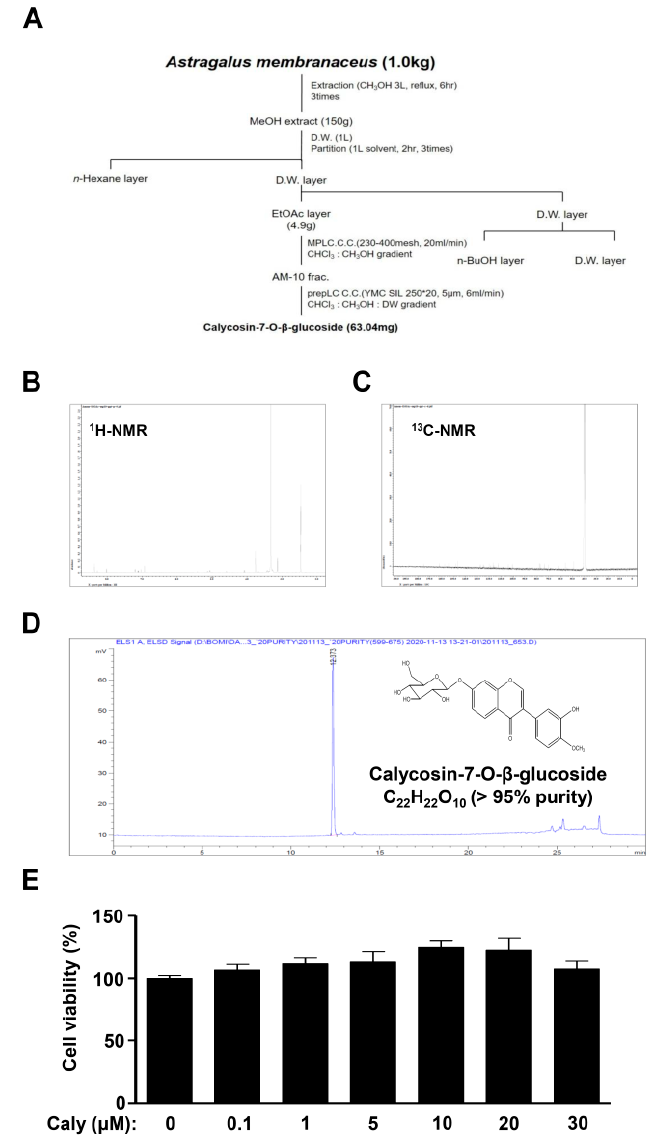
Figure 1. Isolation of Caly from the roots of A. membranaceus , and its effects on cytotoxicity against MSCs. ( A ) Roadmap of Caly isolated from root of A. membranaceus . ( B , C ) 1 H and 13 C NMR of Caly. ( D ) HPLC and chemical structure of Caly. ( E ) Caly (0.1, 1, 5, 10, 20, and 30 μ M) was treated for 24 h in MSCs, and cell viability was analyzed using an MTT assay. Data are representative of three separate experiments.